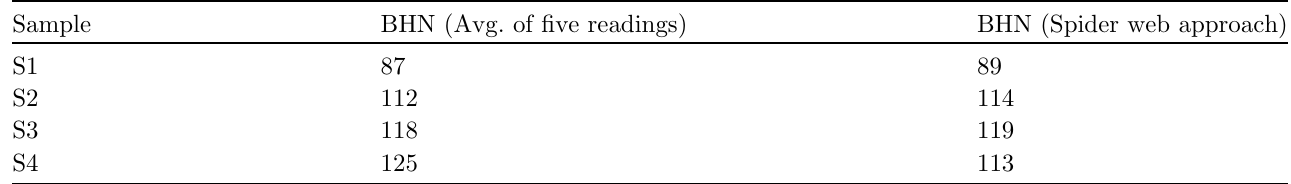
Table 4. Peak hardness of samples by Spider web approach.